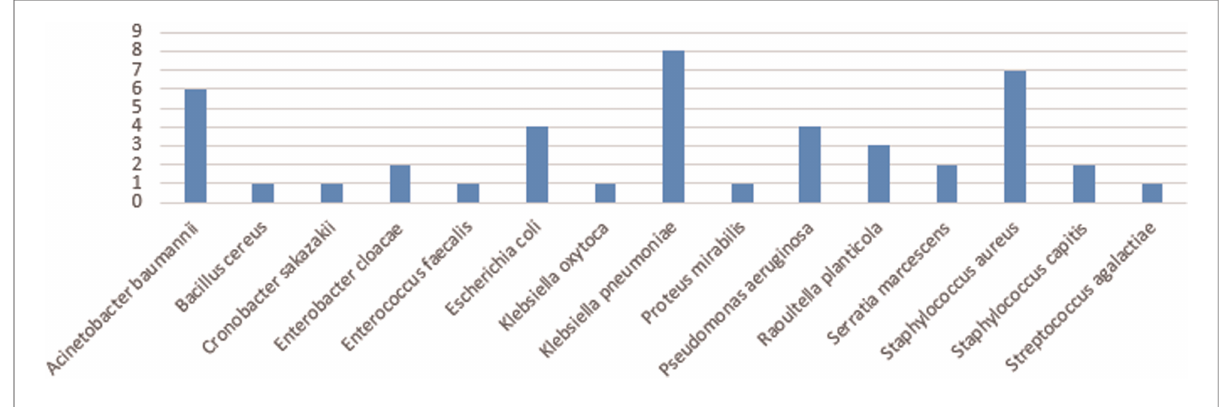
FIGURE 4 CLABSI-causative organisms in both types of catheters across the 4 years.